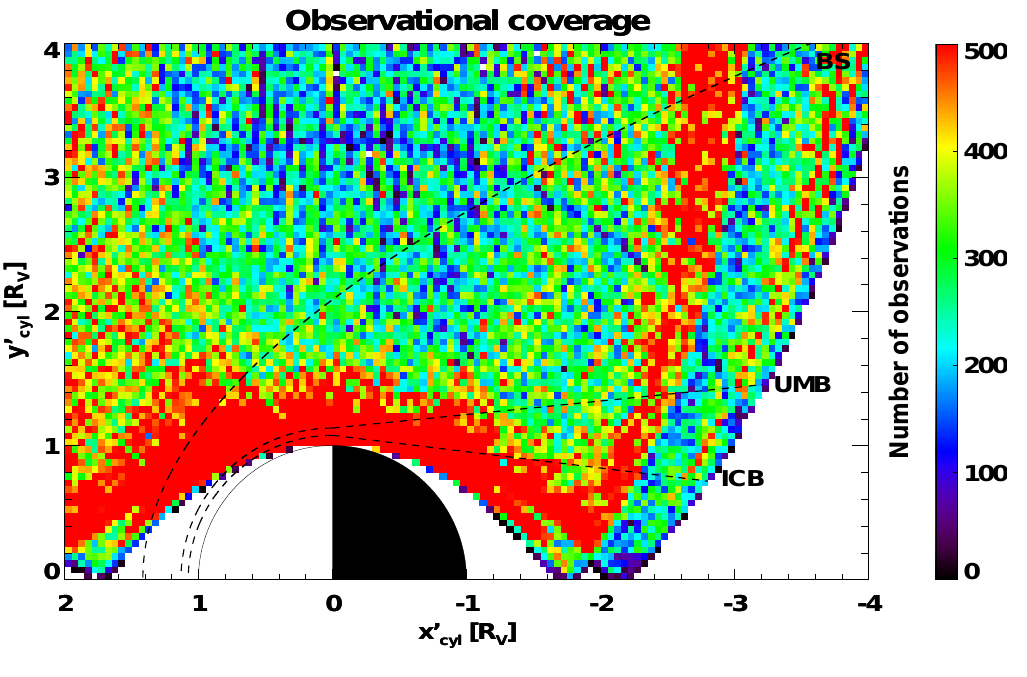
Fig. 2. Observational coverage. Almost every bin is well covered by observations, but the spatial distribution is not homogenous. The polar orbit of Venus Express provides in the vicinity of the pericentre relatively more